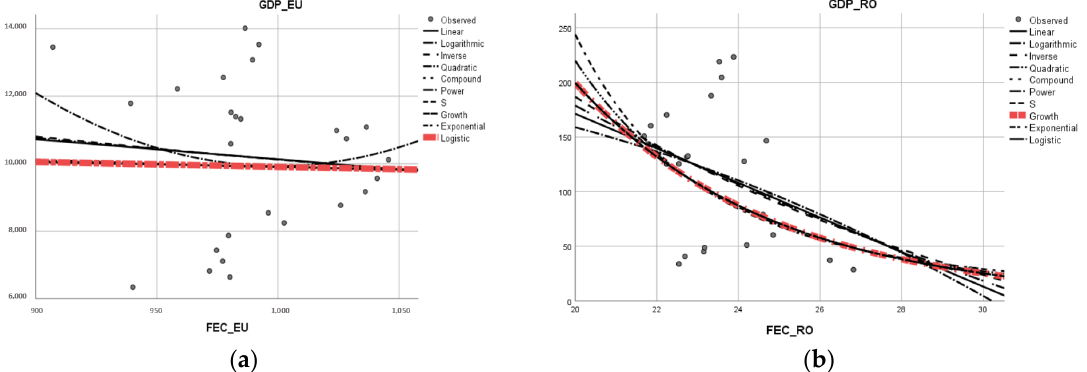
Figure 3. The curve estimation regression models of GDP as a function of FEC (1995–2020): ( a ) EU; ( b ) RO.